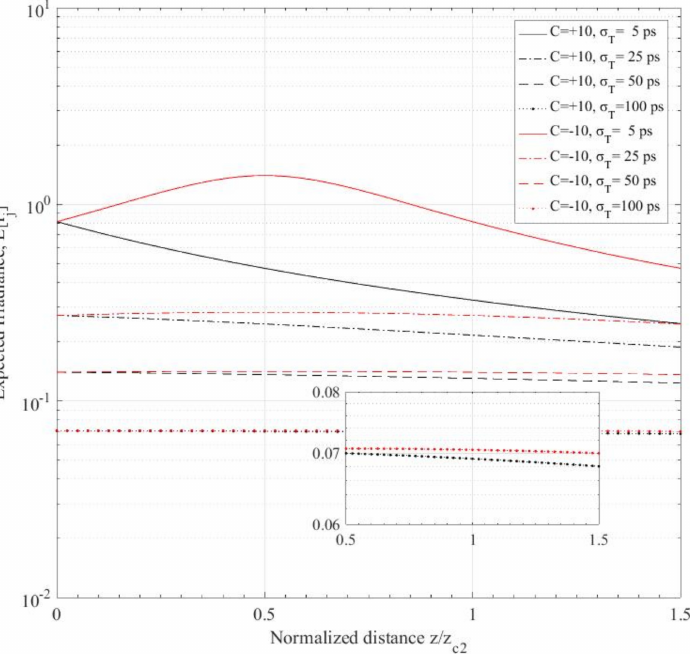
Figure 4. Expected irradiance of a pulse under the joint effect of GVD and TJ as a function of propagation distance ratio, z / z c2